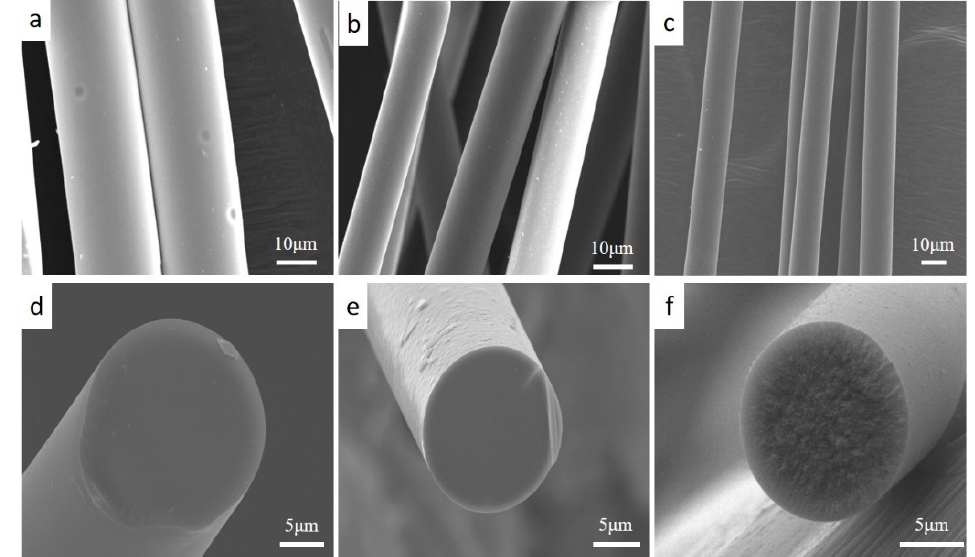
Figure 2. Scanning electron microscopy (SEM) images of the surfaces and cross-sections of the composite fiber: ( a ) and ( d ) show the green fiber after electron-beam curing, ( b ) and ( e ) show the fiber after decarburization pyrolysis at 1000 °C in NH 3 , and ( c ) and ( f ) show the fiber after heat treatment at 1600 °C in N 2 .